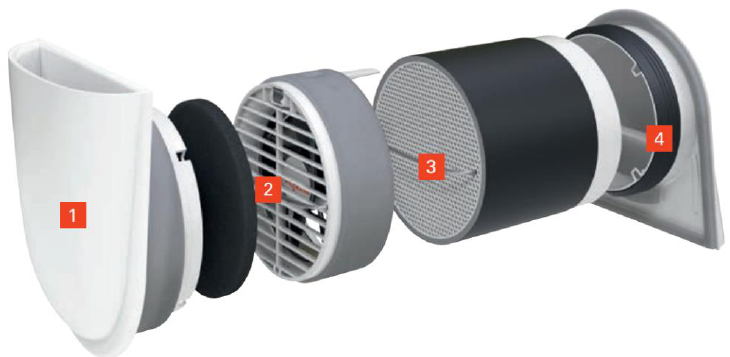
Figure 1. Component arrangements of a typical decentralized regenerative ventilation device (1 — inner wall aperture, 2 — fan, 3 — heat exchanger, 4 — outer wall aperture) [4].